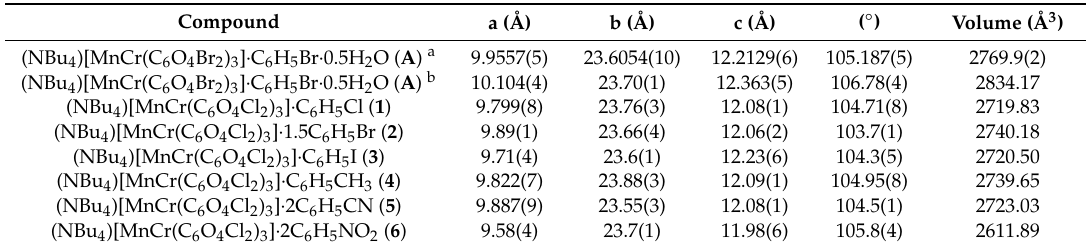
Figure 4. Simulated X-ray powder diffractogram of compound (NBu 4 )[MnCr(C 6 O 4 Br 2 ) 3 ] · C 6 H 5 Br · 0.5H 2 O ( A ) and experimental diffractograms of compounds 1 – 6 . Table 4. Unit cell parameters of compounds 1 – 6 determined from their X-ray powder diffractograms at room temperature.